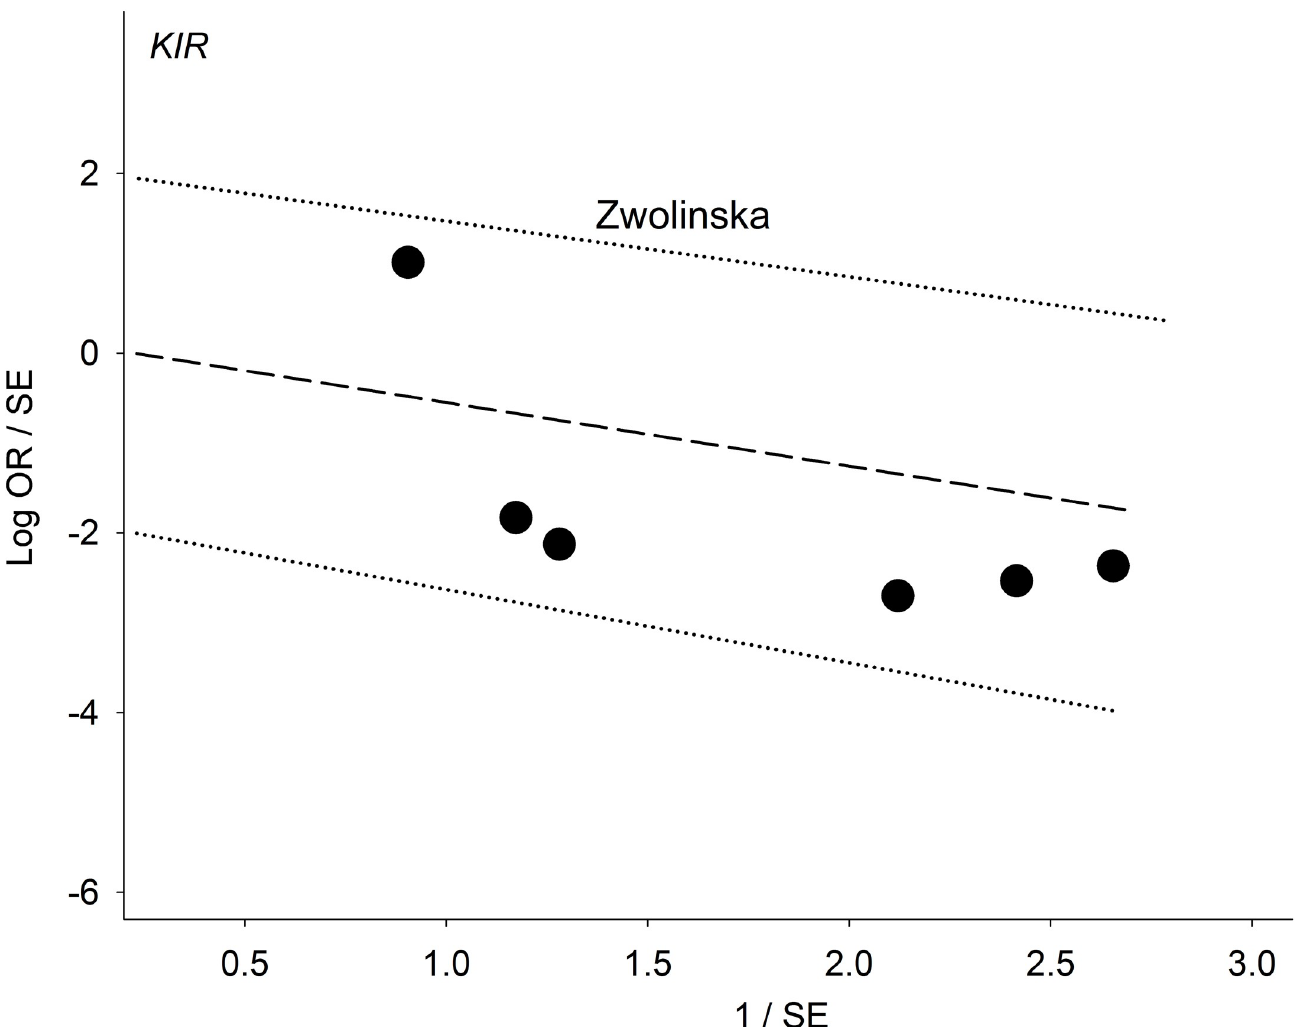
Fig 3. Galbraith plot analysis to detect the source of heterogeneity among Caucasian studies; the study above the +2 confidence limit is the outlier, Zwolinska et al [44]; whose presence in the PRO forest plot (Fig 2) accounts for 50% of the heterogeneity. Removal of this study [44] from the PSO forest plot (Fig 4) reduced the heterogeneity to 5%. OR: odds ratio; SE: standard error.